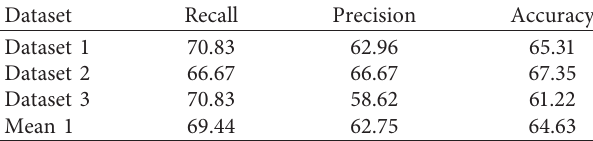
Table 5: Results of SVM model for Datasets 1–3.